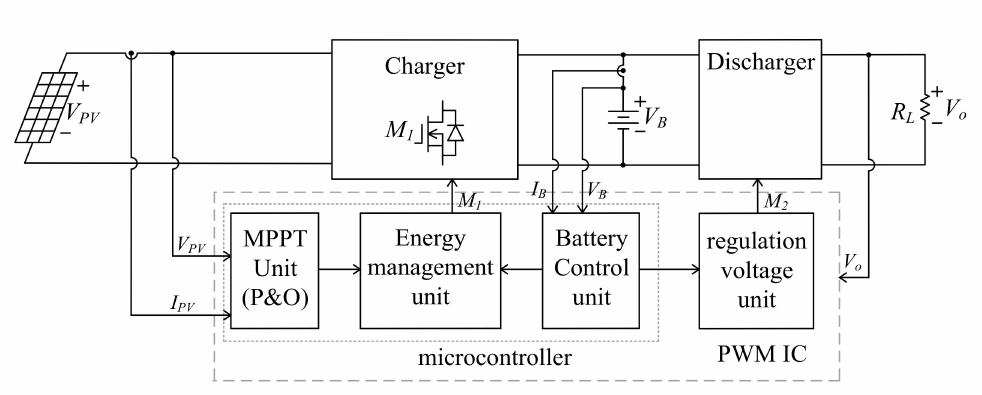
Figure 15. Block diagram of the proposed hybrid converter for solar power system